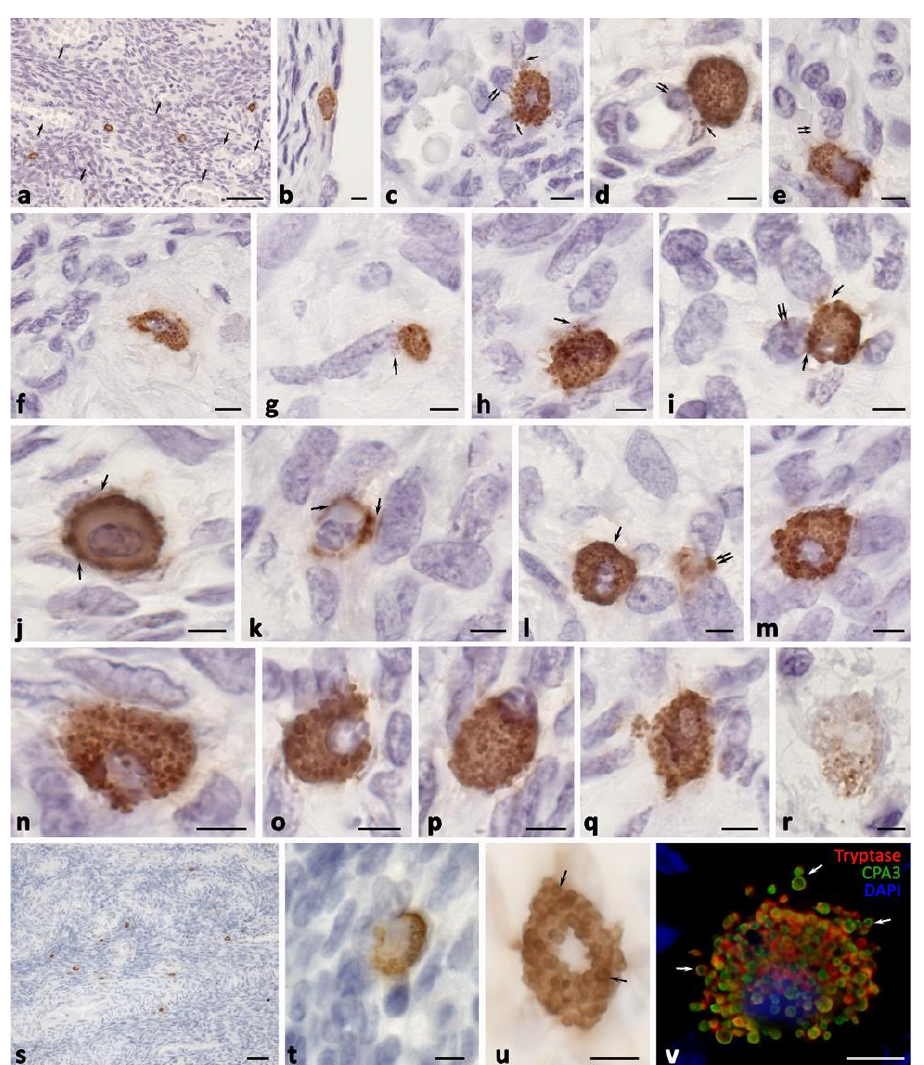
Figure 1. Mast cells of the ovary without pathological changes. ( a – r) Immunohistochemical staining of tryptase, ( s – u ) immunohistochemical staining of CPA3, and ( v ) double immunolabeling of tryptase and CPA3. Notes: ( a ) General view of the ovarian medulla. Vessels are well-marked (indicated by an arrow) and there are isolated MCs in the cytogenic stroma. ( b ) MCs on the surface of the protein membrane (the surface epithelium at the site of MC attachment was not preserved). ( c – e ) MCs in the perivascular space with targeted tryptase secretion to the endothelium (indicated by an arrow), with induction of transendothelial migration of a lymphocyte ( c , d ) (indicated by a double arrow) and neutrophilic granulocytes ( e ) (indicated by a double arrow). ( f ) MCs in the structures of the albuginea. ( g – i ) Variants of fibroblast-oriented tryptase secretion in the cytogenic stroma (indicated by an arrow), localization of tryptase in the nucleus (( i ), indicated by a double arrow). ( j , k ) Peripheral arrangement of granules in the cytoplasm, targeted tryptase secretion through the mechanism of transgranulation to cells of the cytogenic stroma ( j ) and fibroblasts ( k ) (indicated by an arrow). ( l ) Tryptase secretion from MCs (indicated by an arrow) and secretory granules (indicated with a double arrow). ( m – r ) Sequence of the MC denucleation mechanism by gradual displacement of the nucleus to the periphery ( m – p ), with the formation of a nuclear-free cytoplast ( q ) and gradual loss of tryptase content in secretory granules ( r ). ( s ) Location of CPA3-positive MCs in the perivascular cytogenic stroma of the ovary. ( t ) Attachment of CPA3-positive MCs to several stromal cells simultaneously. ( u ) Predominant CPA3 localization in the secretory granules of MCs (indicated by an arrow). ( v ) Colocalization of tryptase and CPA3 in secretory granules, which persists after secretion into the extracellular matrix (indicated by an arrow). Scale: ( a , s ) 50 µ m, the rest—5 µ